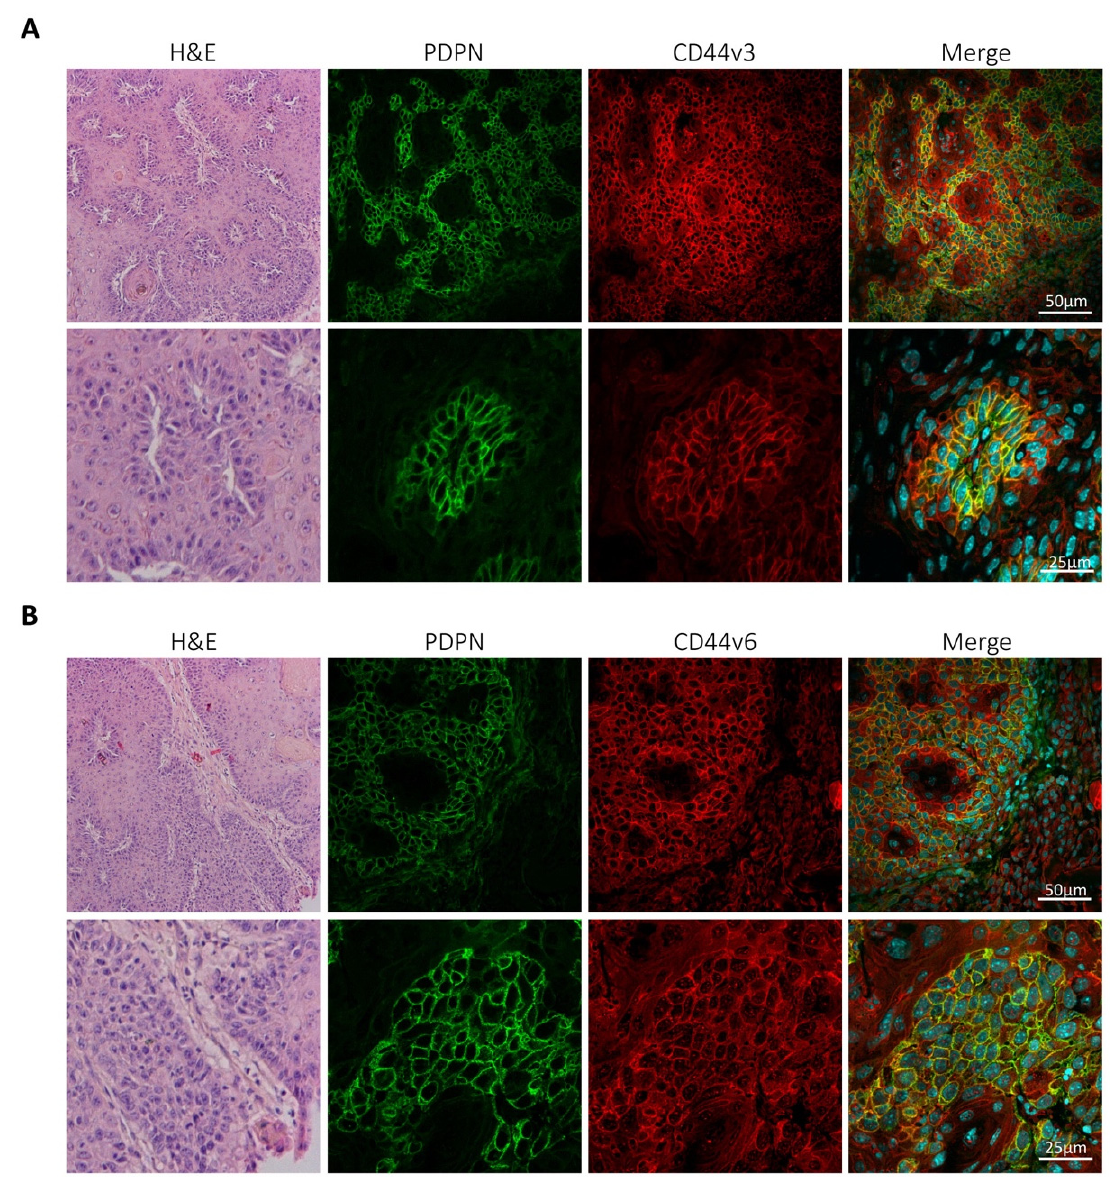
Figure 2. Colocalization of podoplanin with CD44v isoforms in chemically induced mouse-skin squamous carcinoma cell (SCC). Tumor skin sections were double stained with a rat mAb specific for podoplanin (PDPN) and rabbit polyclonal Abs recognizing sequences encoded by the ( A ) CD44 v3 or ( B ) v6 exon and appropriate secondary Abs. Nuclei stained with 4 ′ ,6-diamino-2-phenilindole (DAPI). Merge images show a colocalization of podoplanin and CD44 isoforms containing v3 or v6 exons in the tumors. Representative images from three different tumors in each case are shown.